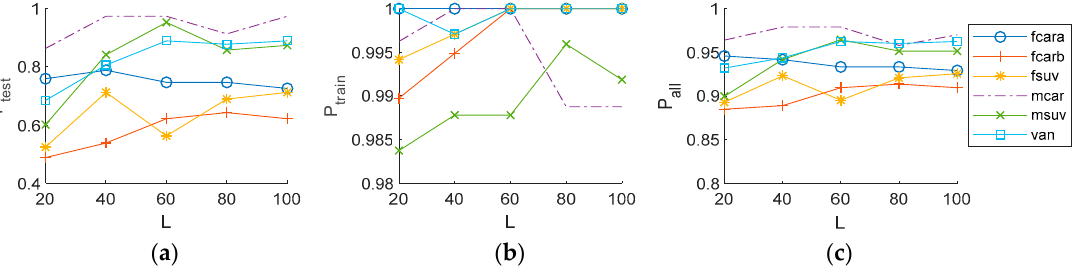
Figure 10. The curve of the overall accuracy changing with the size of the image at different β . ( a ) The accuracy of the test set; ( b ) The accuracy of the training set; and, ( c ) The accuracy of all images.